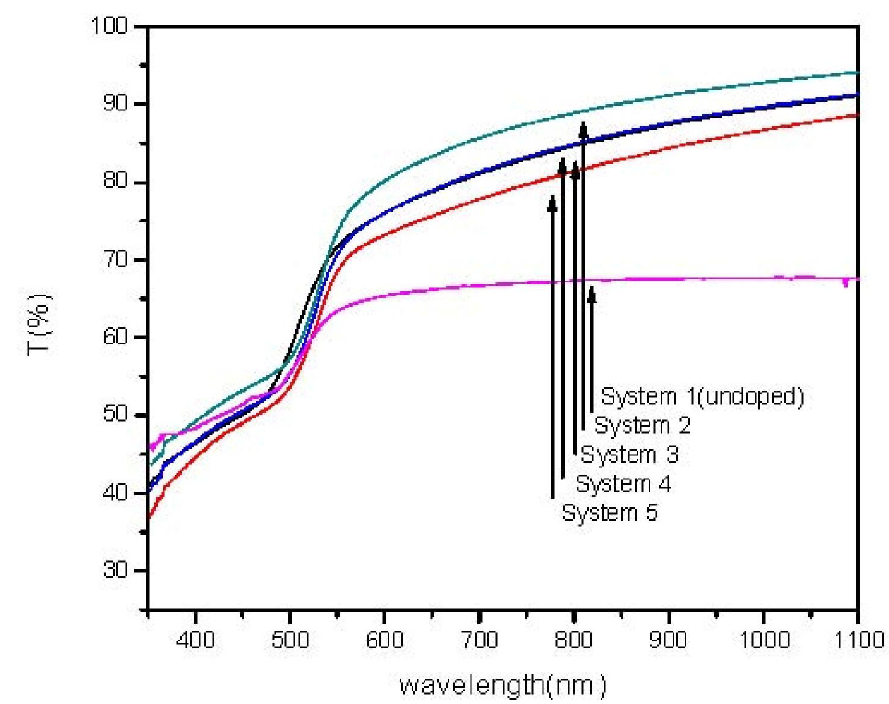
Figure 2. The transmittance spectra for all systems.